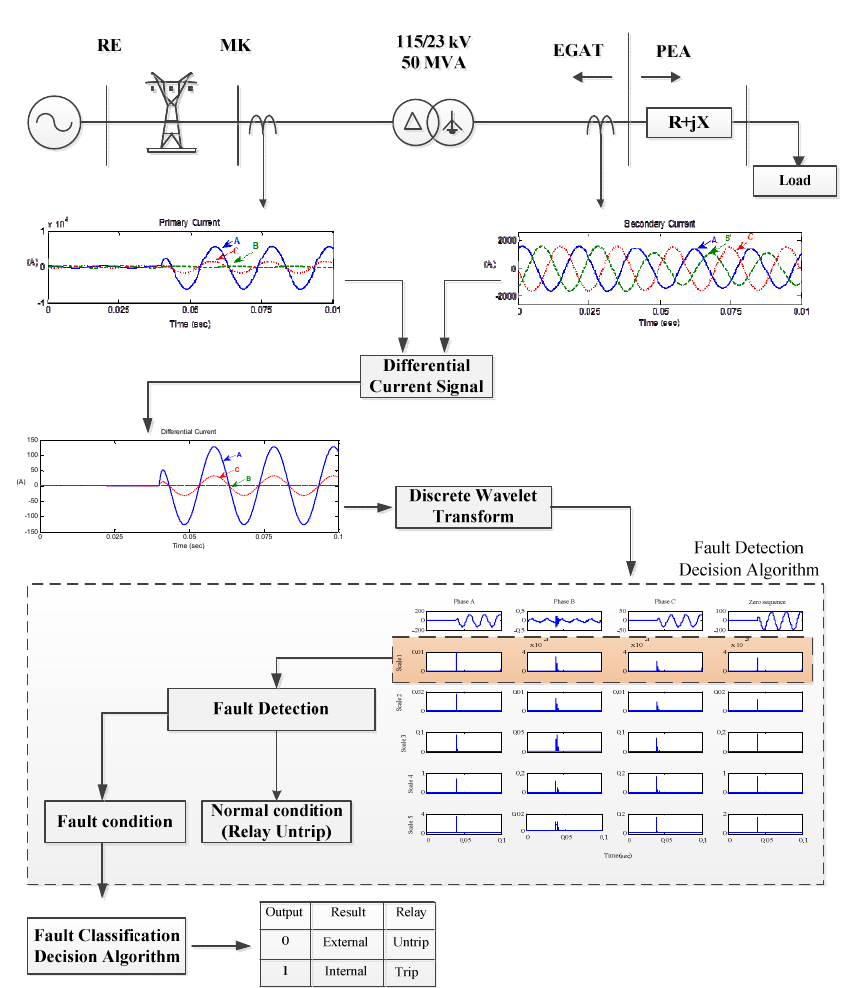
Figure 2. Diagram of the suggested fault ‐ classification algorithm in simplified form.